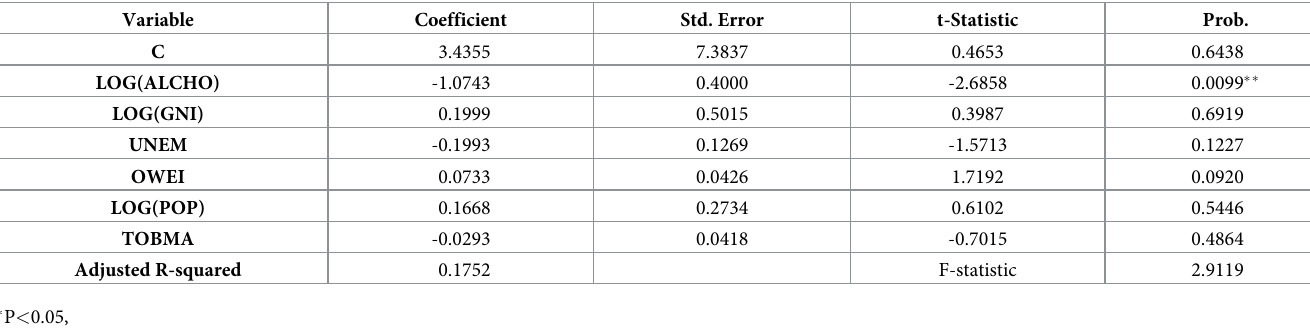
insignificance of the majority of the independent variables further confirms the weakness of the model specification. To illustrate, according to Model 2B results, five out of six indepen- dent variables turn out to be statistically insignificant at the 5% level of significance. On the other hand, all six variables are statistically significant in low volatility countries. As a result, we focus on Model 2A results that we estimated from 77 low volatility countries and leave out Model 2B results based on 55 high volatility countries in the subsequent analysis. Spatial distribution of low volatility countries. The spatial distribution of the low and high volatility countries are shown in blue and red respectively on the map below (Fig 3). A number of high and upper middle income countries were excluded from the analysis due to high heteroscedasticity including countries within Northern Europe; South West Asia;